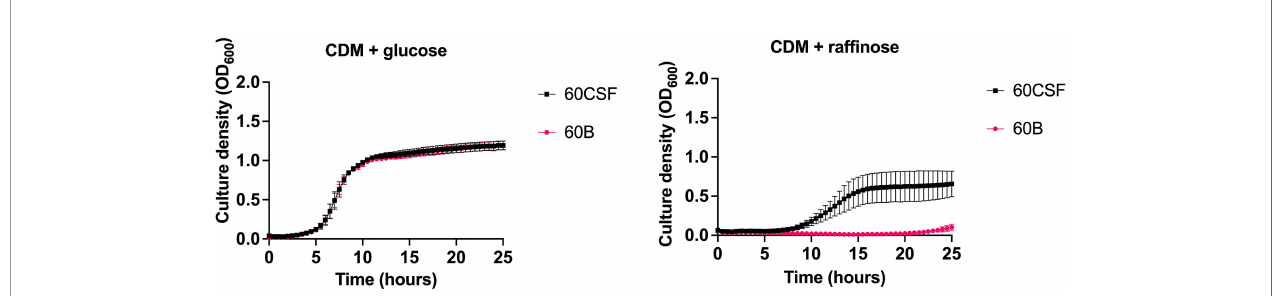
FIGURE 1 | Growth of 60B and 60CSF in CDM + glucose and CDM + raf fi nose. S. pneumoniae serotype 15C ST8711 blood isolate (60B) and CSF isolate (60CSF) were grown in 200 m L CDM supplemented with 0.5% glucose (CDM + glucose) or 0.5% raf fi nose (CDM + raf fi nose). OD 600 was measured every 30 min for 24 h. Data are mean OD 600 ± standard error mean (SEM) from three independent assays, each performed in triplicate.